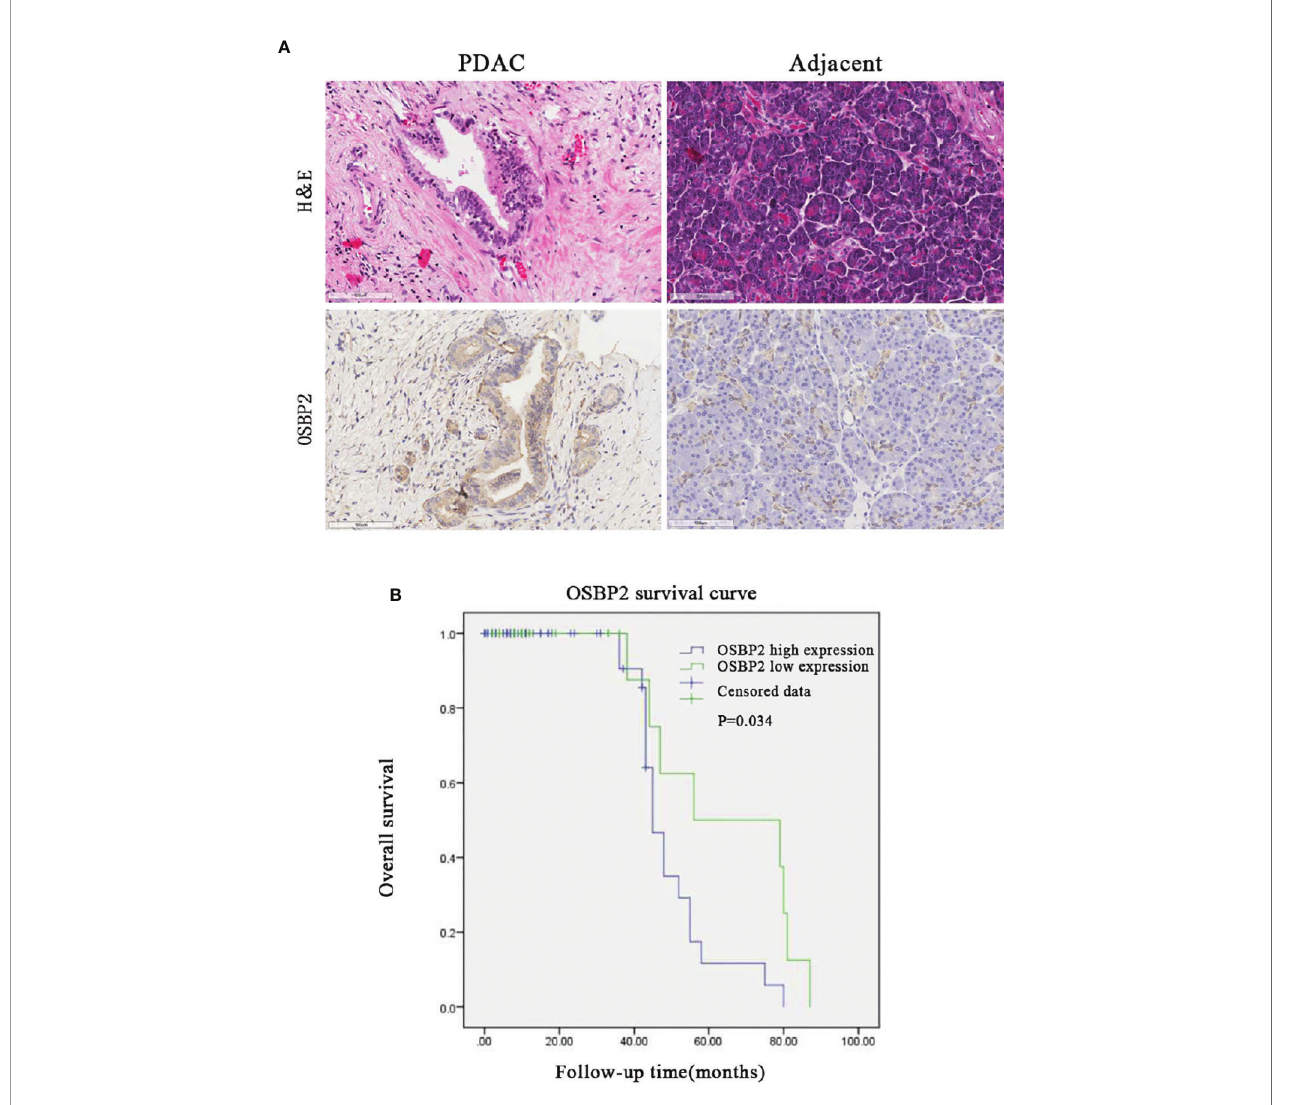
FIGURE 1 | High OSBP2 expression in PDAC correlates with shorter survival. (A) Expression of OSBP2 in pancreatic cancer tissues and paired adjacent paracancerous tissues (Scale bars, 100 m m). (B) Association between OSBP2 expression in tumors and overall survival in 100 PDAC patients (P = 0.034 by log-rank test). OSBP2, oxysterol-binding protein 2; PDAC, pancreatic ductal